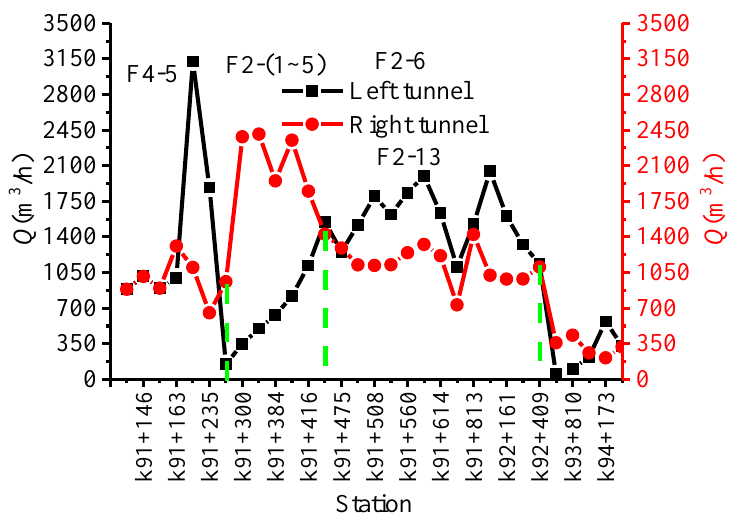
Figure 9. Relationship between water inflow and station.